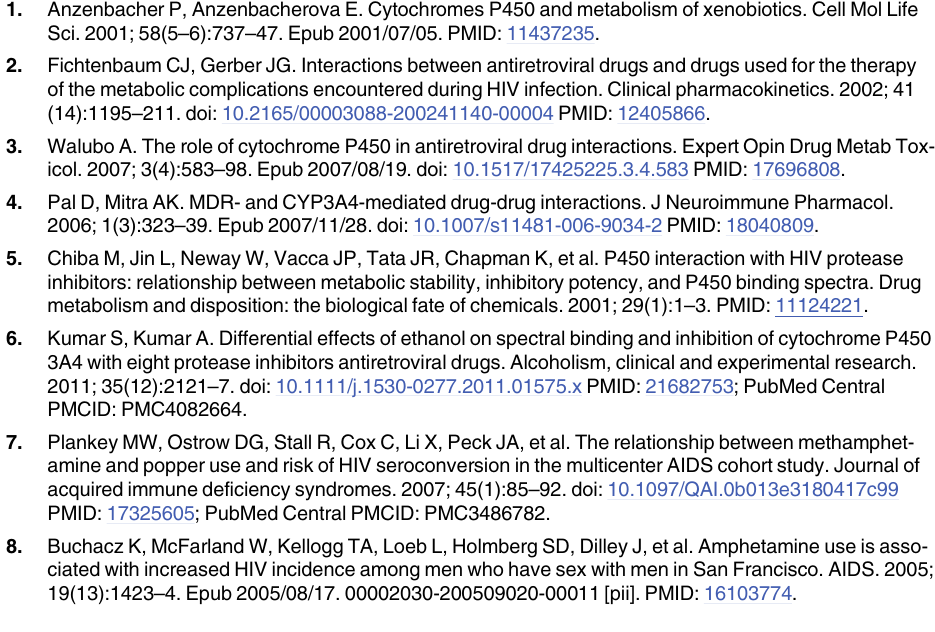
S1 Table. The difference in docking scores and clusters of CYP3A4 bound with ligands between with and without the presence of methamphetamine